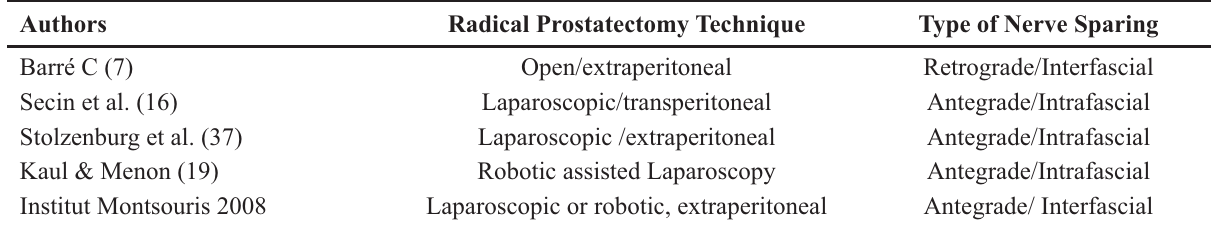
Table 2 – Variations on technique, approach and type of nerve sparing for radical